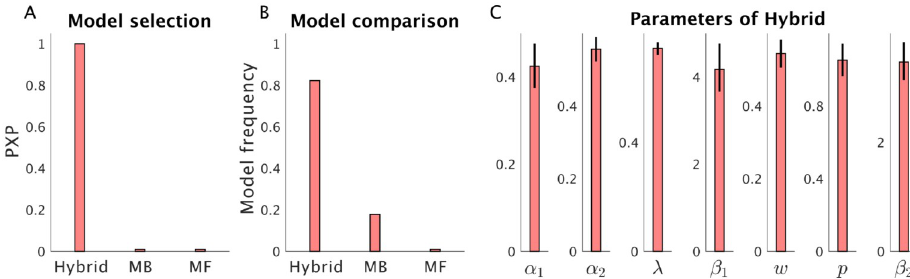
Fig 13. Using HBI for making inference on empirical datasets. A) HBI has been applied to a dataset of the two-step Markov decision task. The model space consisted of the hybrid, the model-based (MB) and the model-free (MF) models. Protected exceedance probabilities (PXP), model frequencies and estimated parameters of the winning model (the hybrid) are plotted. The error-bars are obtained by applying the corresponding transformation function on the hierarchical errors and, therefore, are not necessarily symmetric.